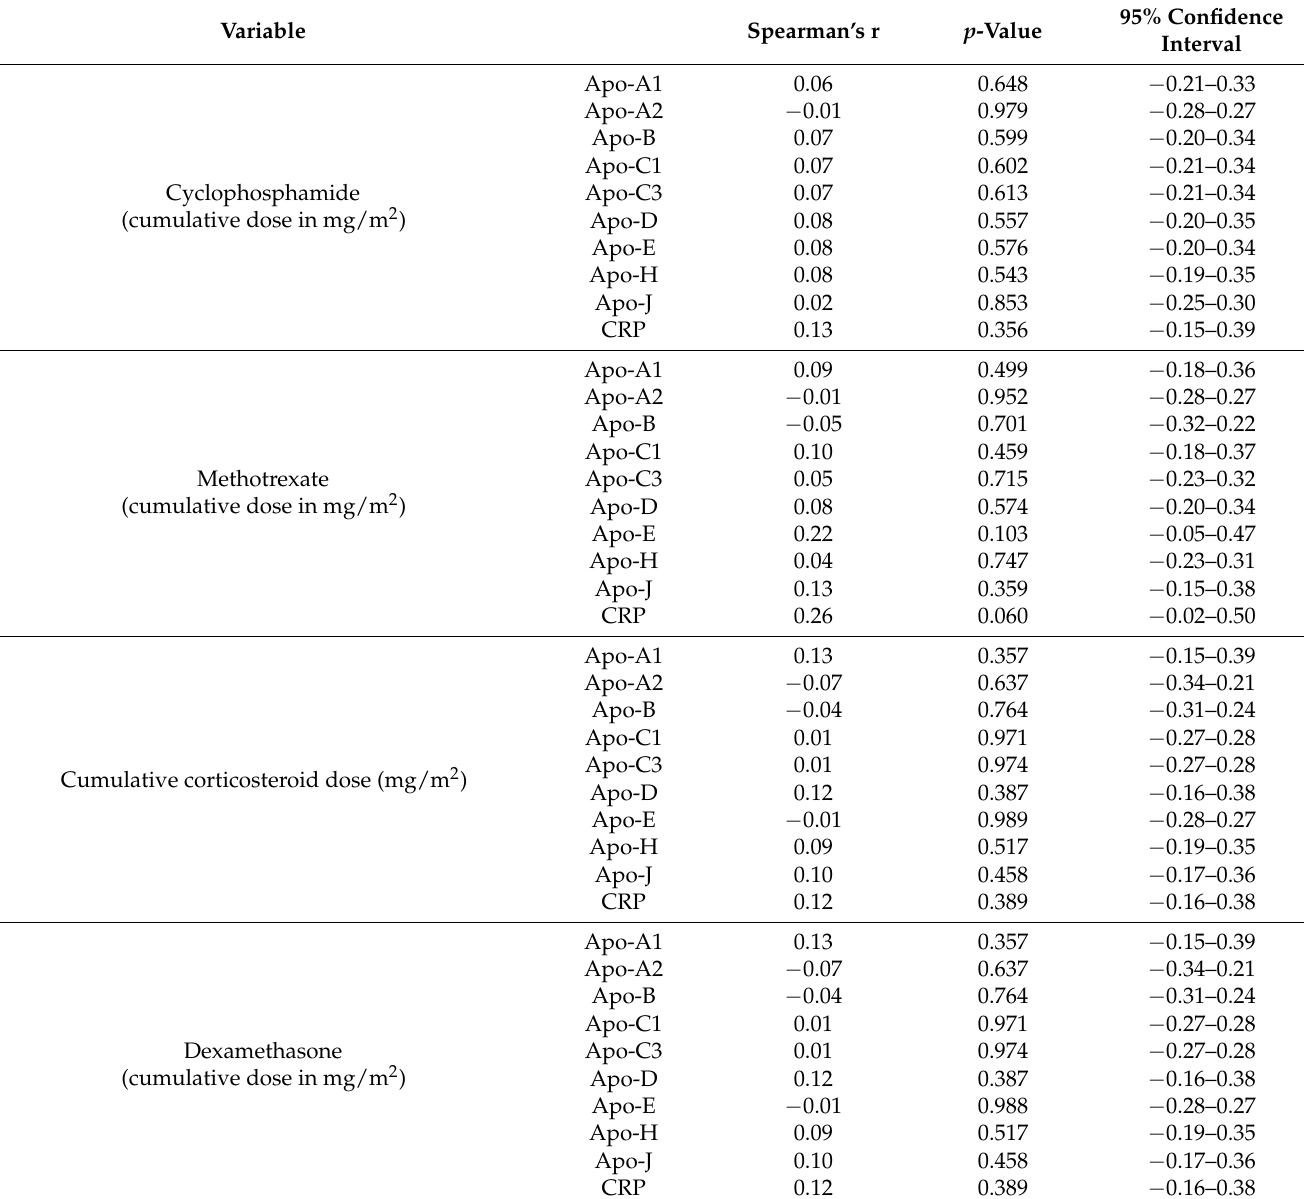
Table 5. Spearman’s rank correlation of apolipoprotein concentrations in patients with acute lym- phoblastic leukemia (ALL), depending on the selected anticancer